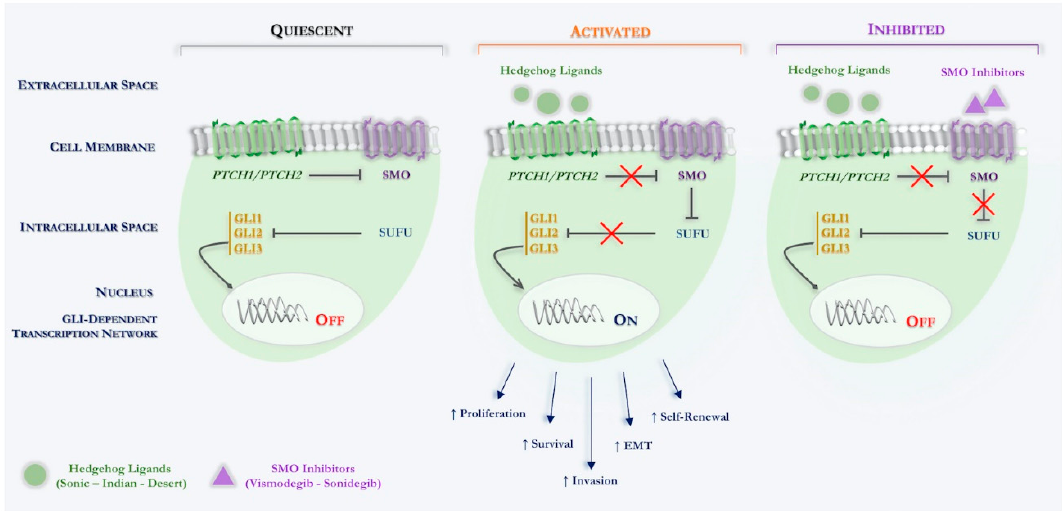
Figure 1. Schematic overview of canonical Hedgehog signaling in Basal Cell Carcinoma. Hh signaling pathway: quiescent: in the absence of an Hh ligand, PTCH inhibits SMO, thus, indirectly permitting SUFU to bind to, and thereby inactivate GLI transcription factors. Activated: binding of an Hh ligand to PTCH relieves PTCH-mediated inhibition of SMO, thereby inhibiting SUFU binding to GLI transcription factors, enabling the latter to enter the nucleus and activate Hh target genes. Inhibited: binding of a SMO inhibitor (vismodegib; sonidegib) relieves SMO-mediated inhibition of SUFU binding to GLI transcription factors, which are thereby inactivated. Abbreviations: PTCH, Patched receptor; Hh, Hedgehog; SMO, Smoothened; GLI, Glioma-associated oncogene homologue; SUFU, Suppressor of fused; EMT, Epithelial-mesenchymal transition.